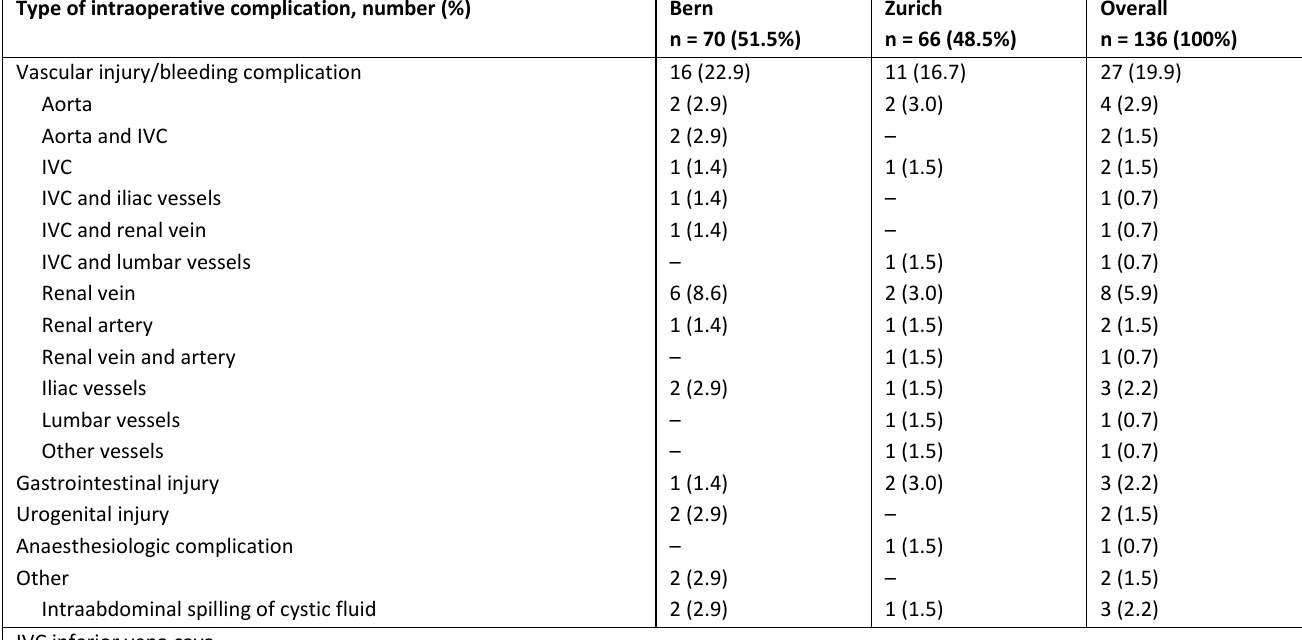
Supplementary table 5. Intraoperative